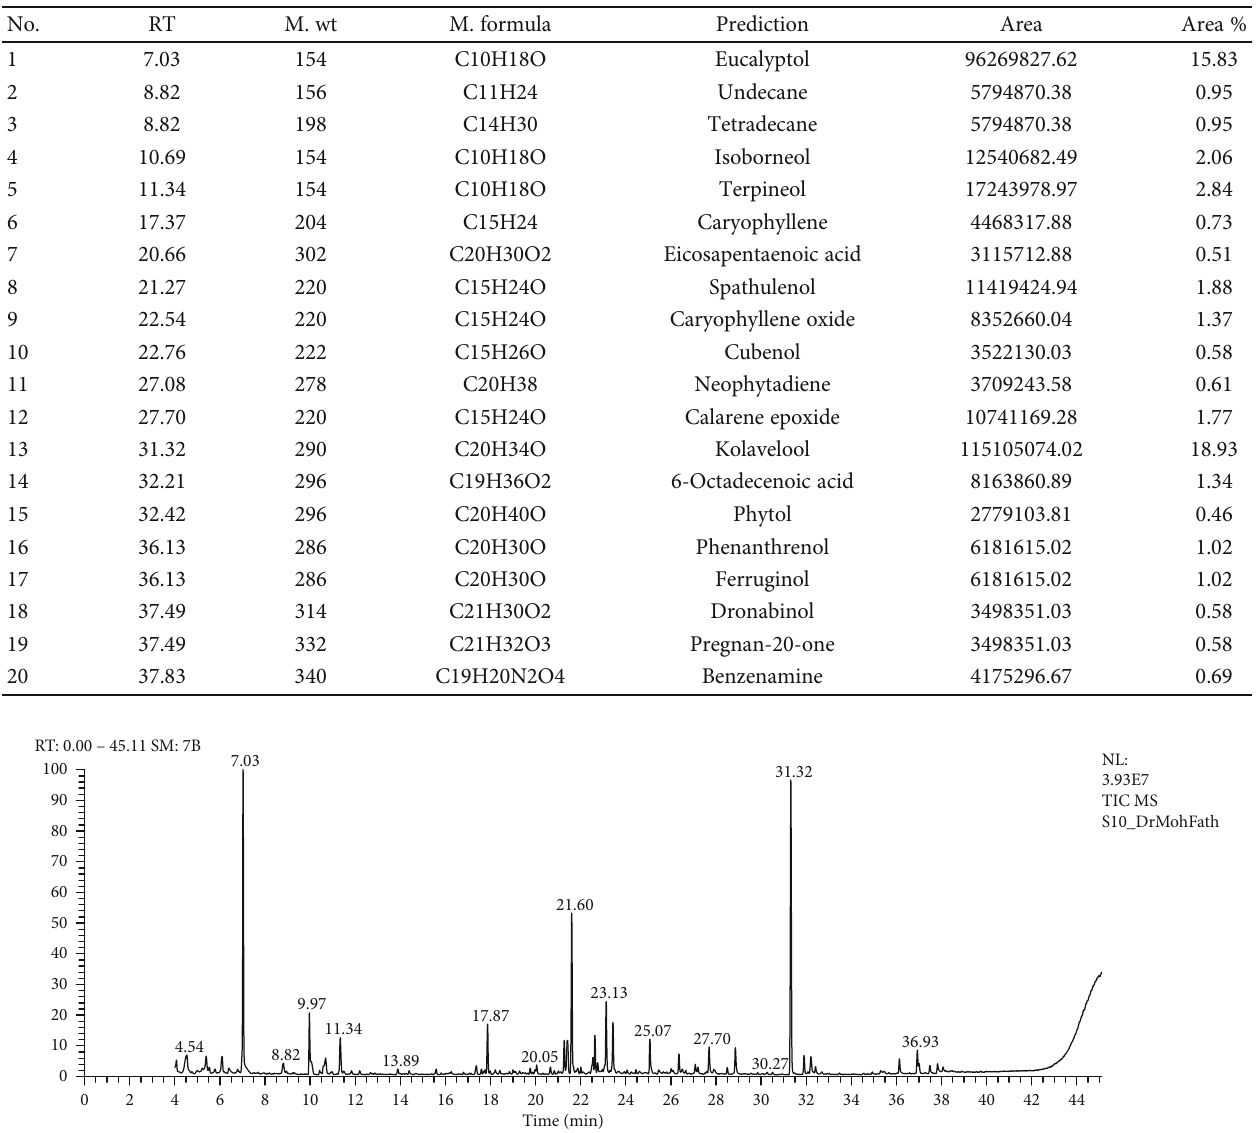
Table 3: Identi fi ed compositions in aqueous extract of Coriandrum sativum .